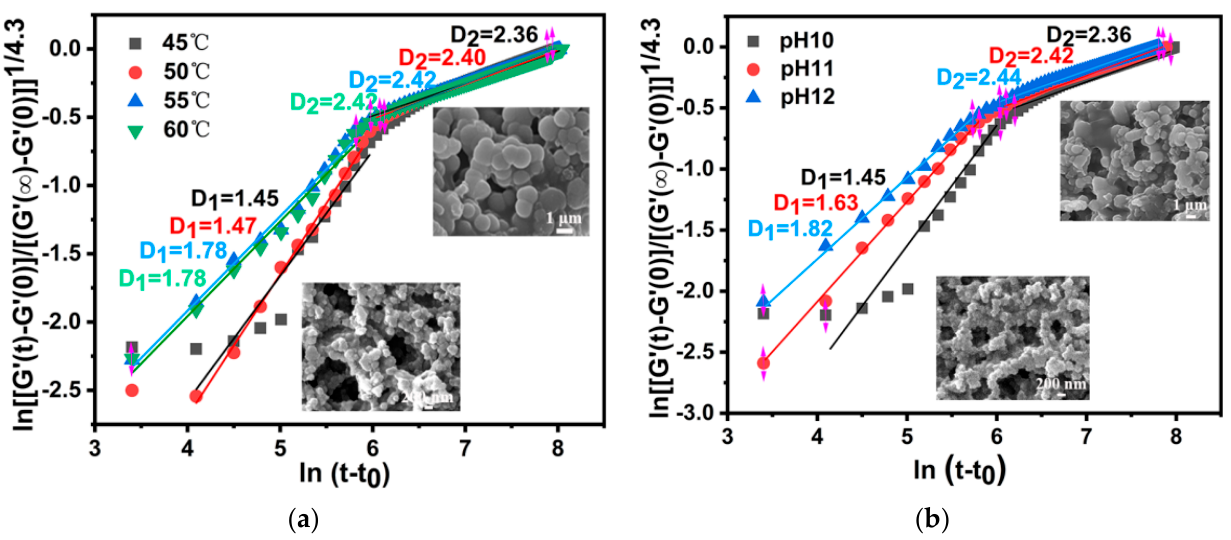
Figure 4. Relationship curves of dense dimension and microstructure of PEG/PAMAM hydrogels under different conditions. ( a ) Temperatures from 45 to 60 °C; ( b ) pH 10.0 to 12.0.